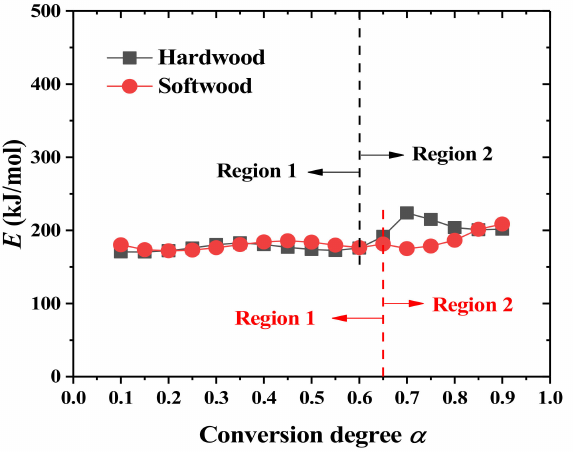
Figure 5. The activation energy as a function of conversion degree for hardwood and